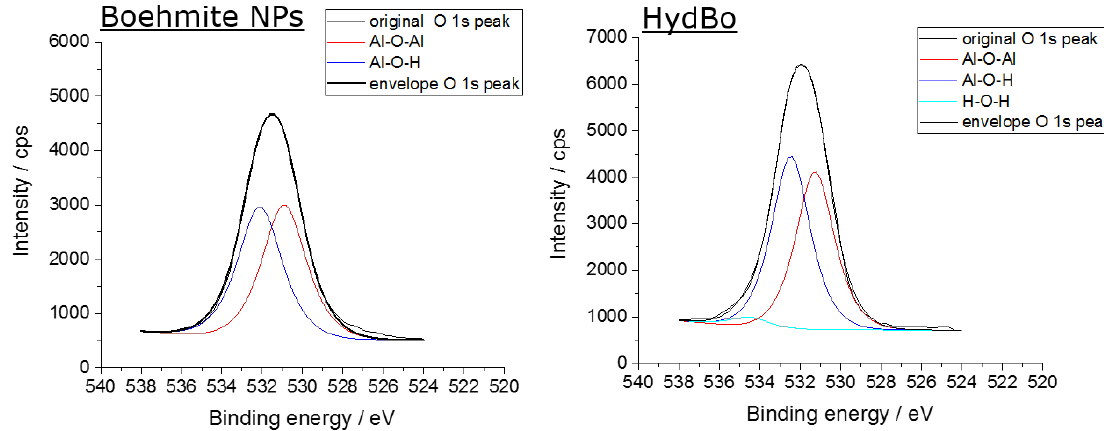
Figure A1. Comparison of Al p2 peak of commercial boehmite nanoparticles NPs (left) and hydrothermally synthesized boehmite layer on epoxy substrate (right).